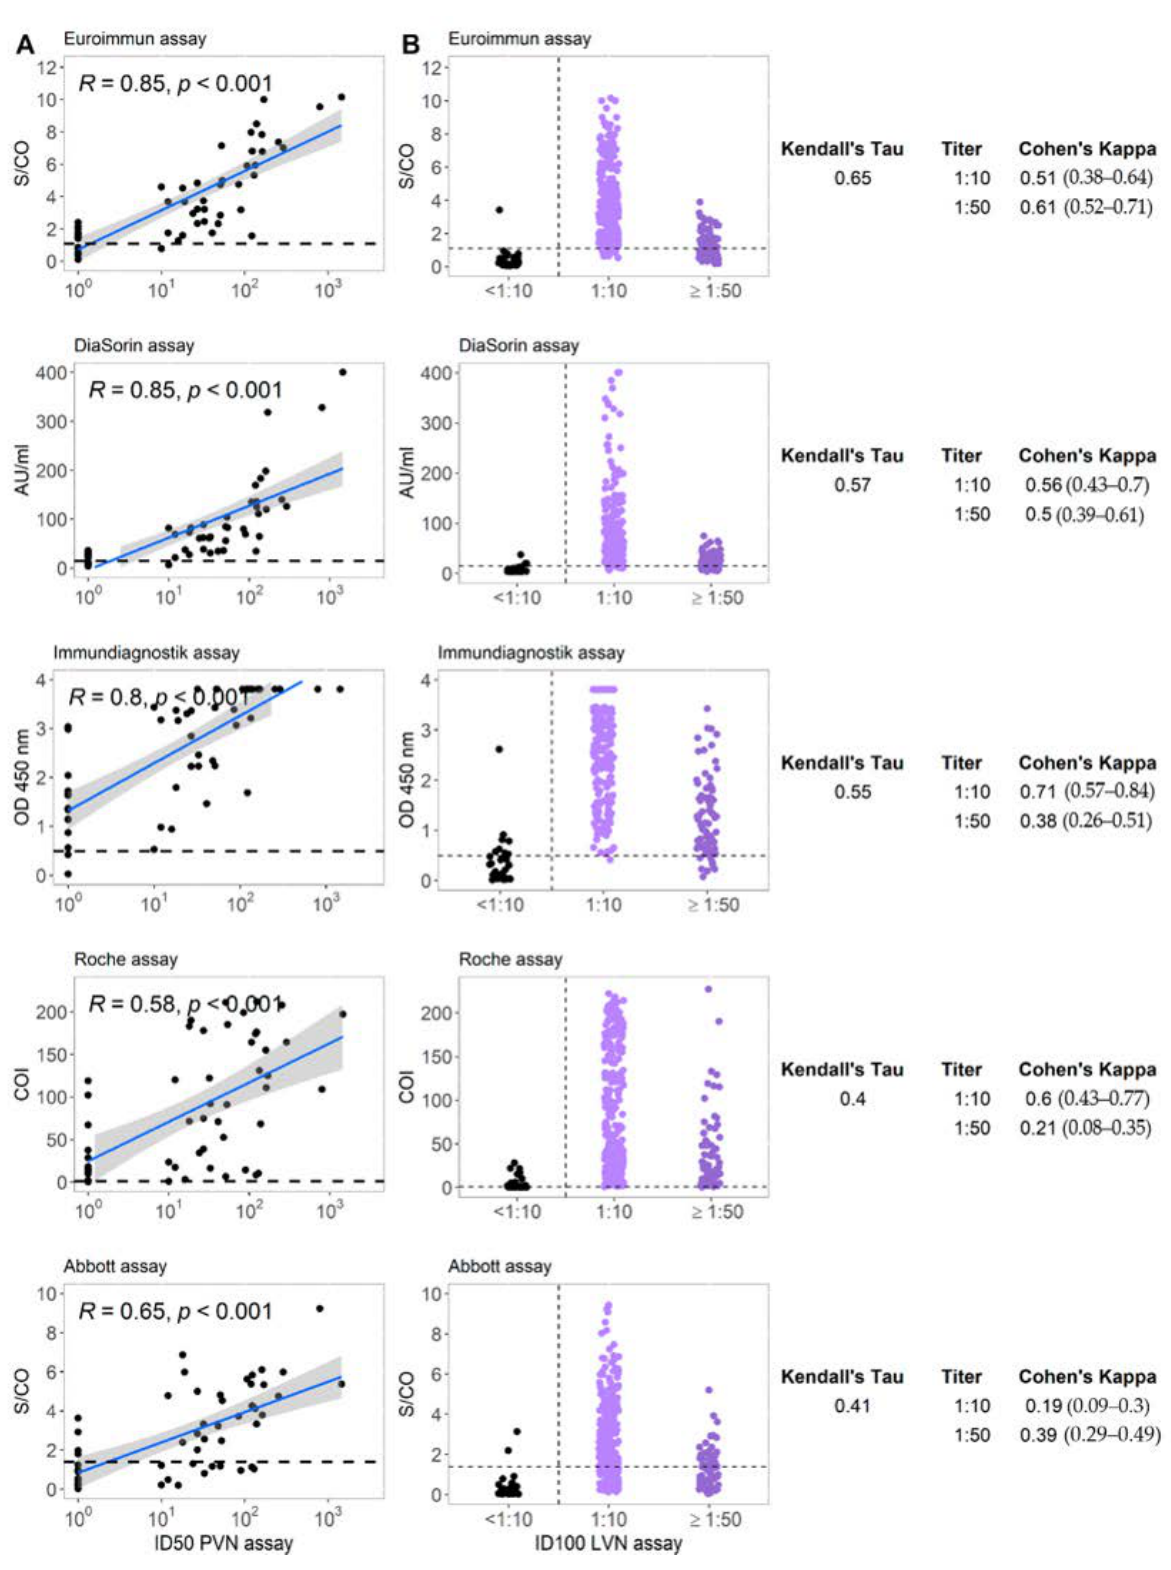
Figure 3. ( A ) Correlation between five commercial anti-SARS-CoV-2 serological assays and a pseudovirus neutralizing antibody titer for group A. R represents the Spearman rank correlation coefficient ρ . ( B ) Correlation between five commercial anti-SARS-CoV-2 serological assays and live virus neutralizing antibody titer for group A. Horizontal lines represent cutoff values for individual commercial tests. Kendall’s τ and Cohen’s κ are displayed for each test combination. LVN, live virus neutralization assay; PVN, pseudovirus neutralization assay; ID100, 100% inhibitory dilution; ID50, 50% inhibitory